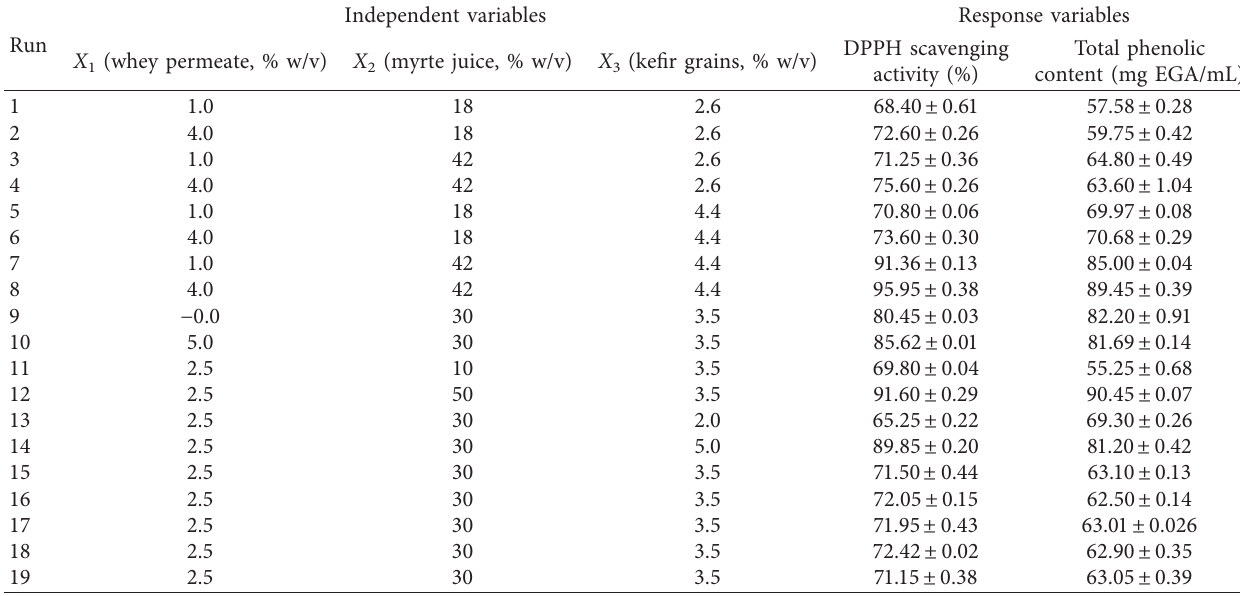
Table 2: Matrix of the central composite design for three variables and the measured responses (DPPH scavenging activity and total phenolic content).